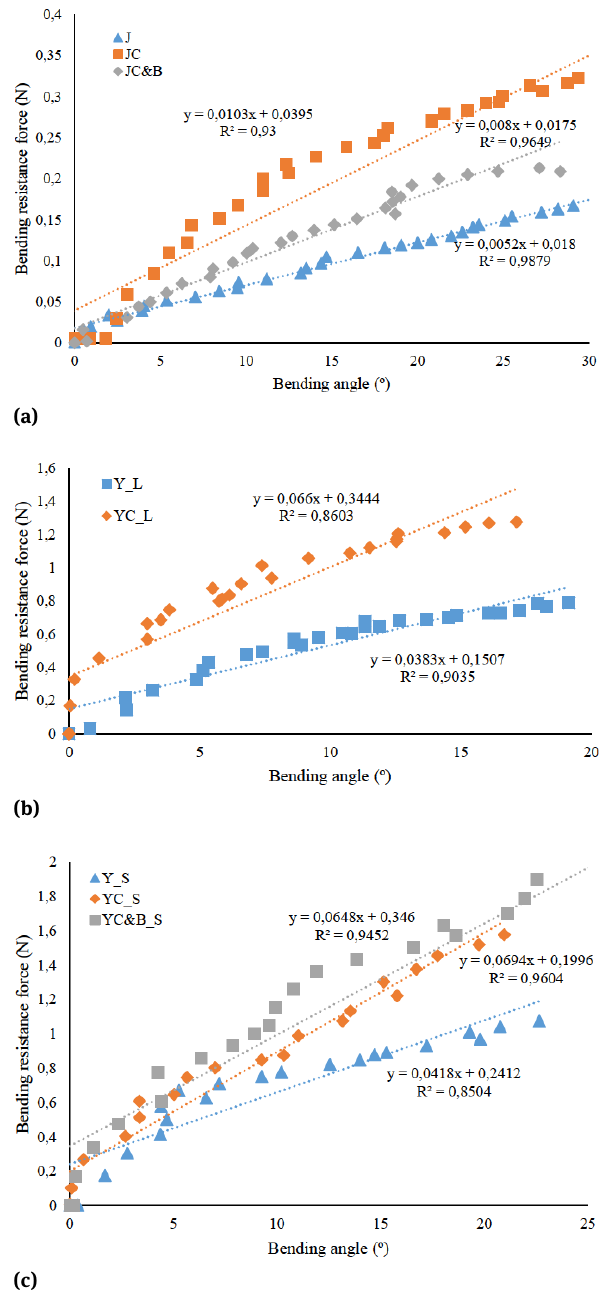
Figure 6: Bending test of (a) three J-shaped stents, (b) long branches of two Y-shaped stents; and (c) short branches of three Y-shaped